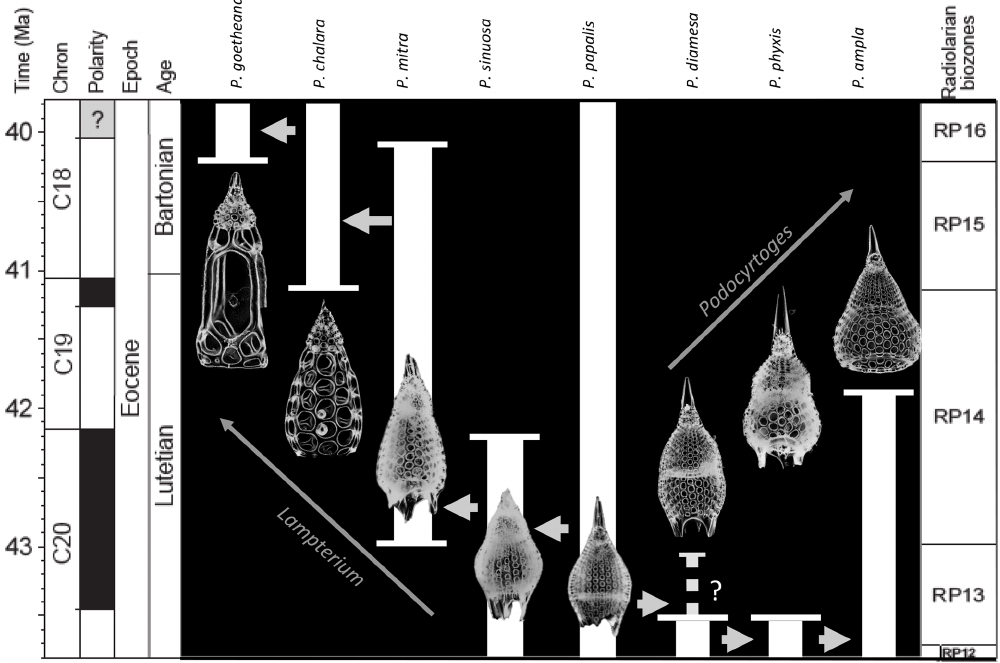
Figure 1. Age range and evolutionary relationships of Podocyrtis species occurring in Hole 1260A modified from Meunier and Danelian (2022). Arrows indicate descending